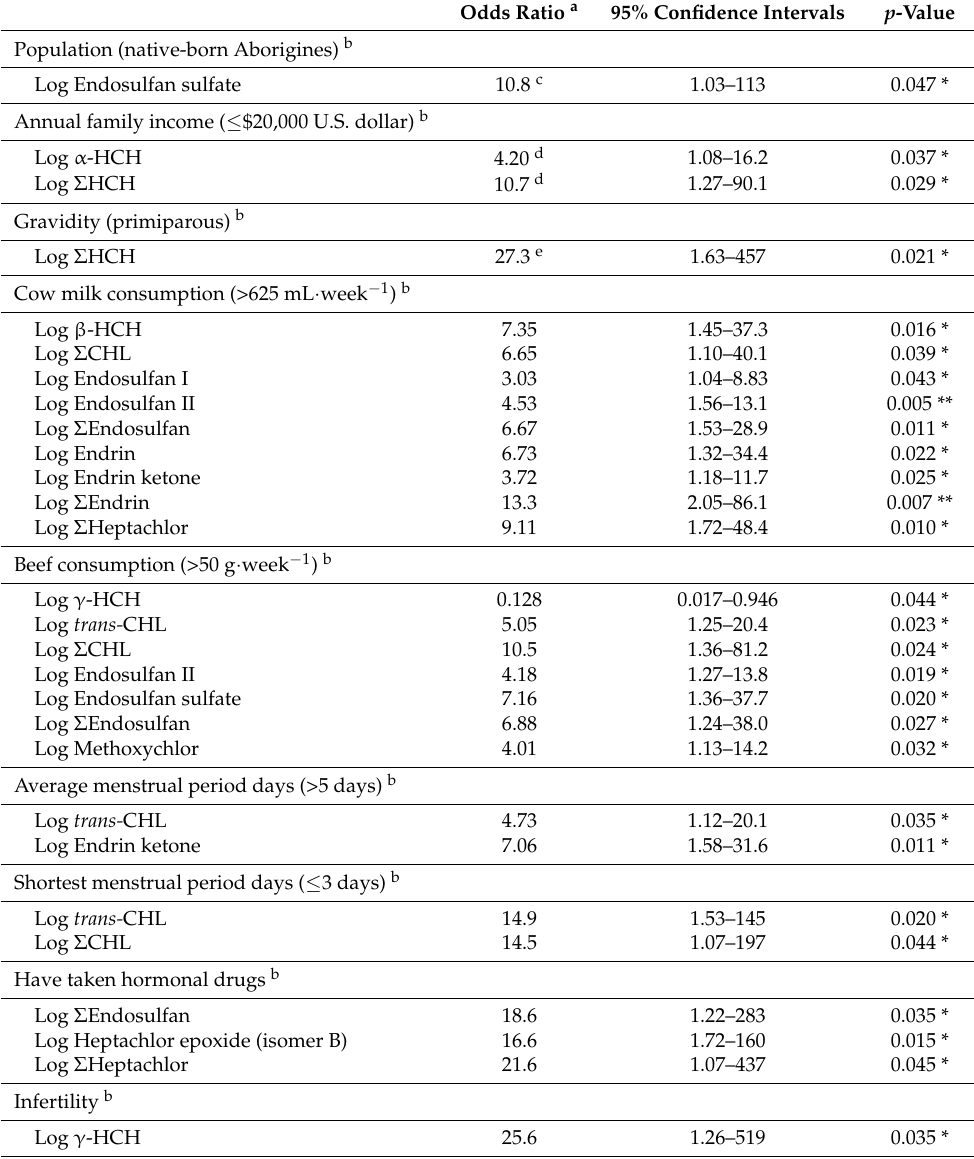
Table 5. Sociodemographic characteristics, dietary habits and menstruation characteristics of mothers in association with OCP residues in breast milk as determined using the logistic regression